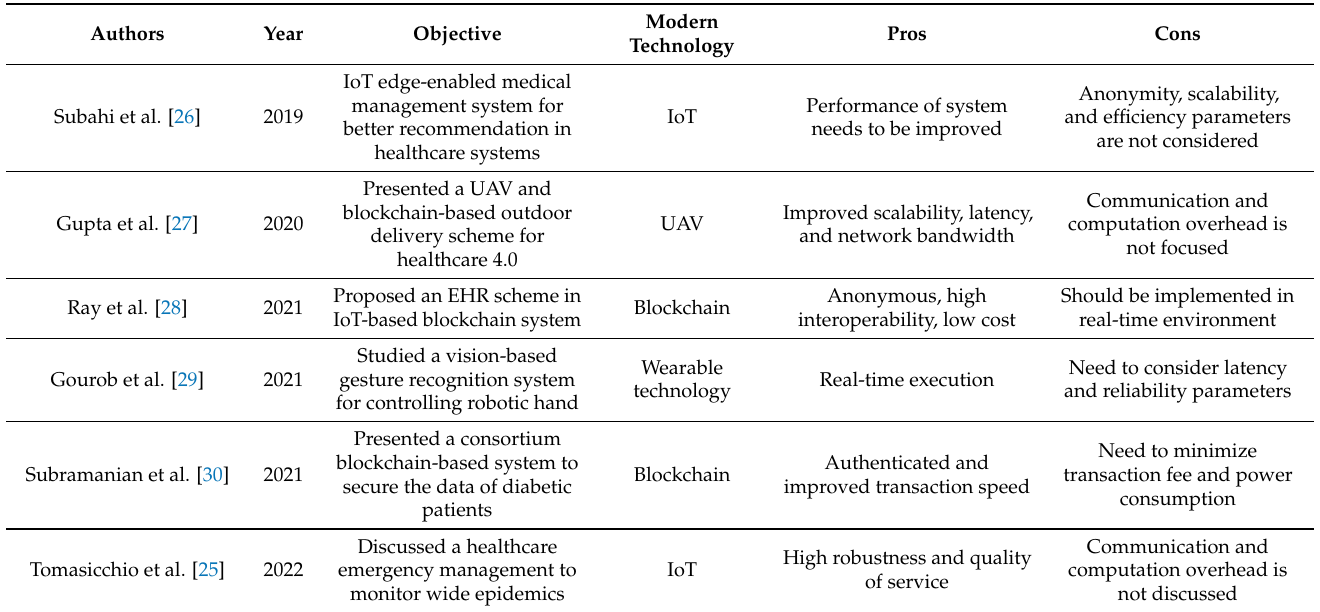
Table 3. Comparative analysis of various modern technologies in smart healthcare